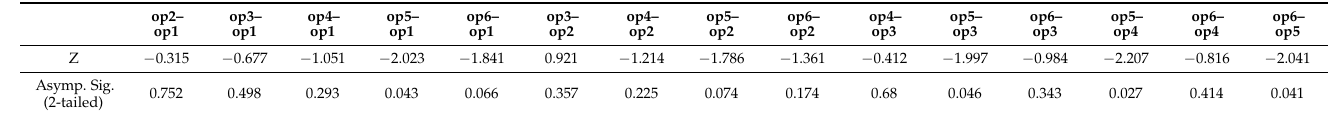
Table 3. Mann–Whitney test, according to which only one outlier between the operators was